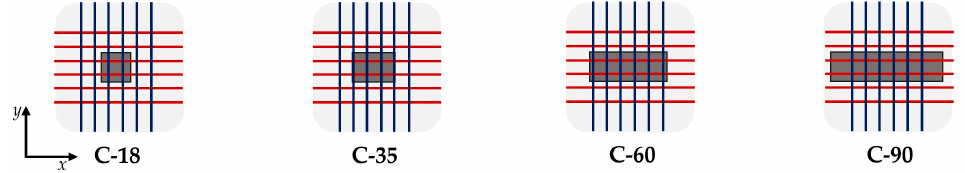
Figure 14. Column dimension settings on Series C models.